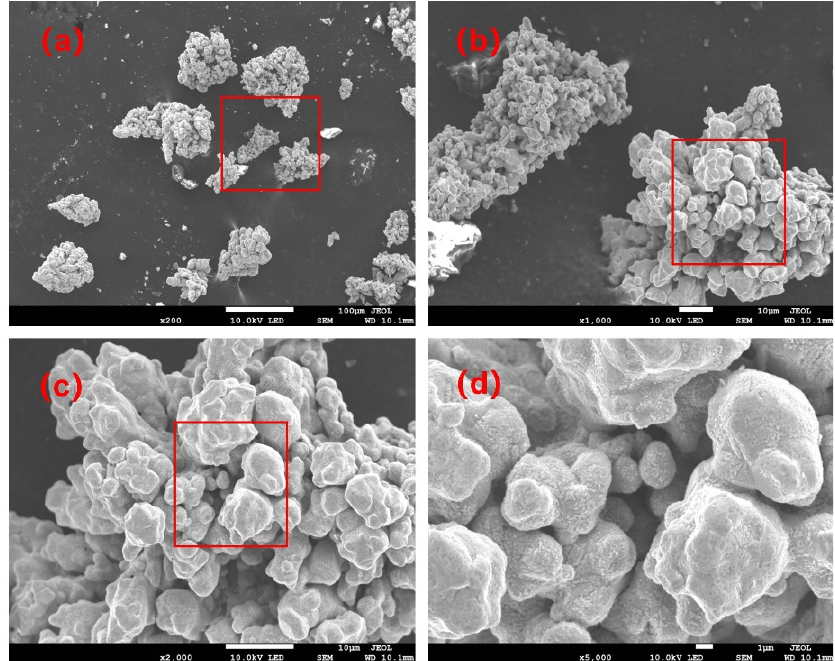
Figure 6. SEM micrographs of the partially oxidized copper powder (the original commercial sample): ( a ) ×200, ( b ) ×1000, ( c ) ×2000, ( d ) ×5000.